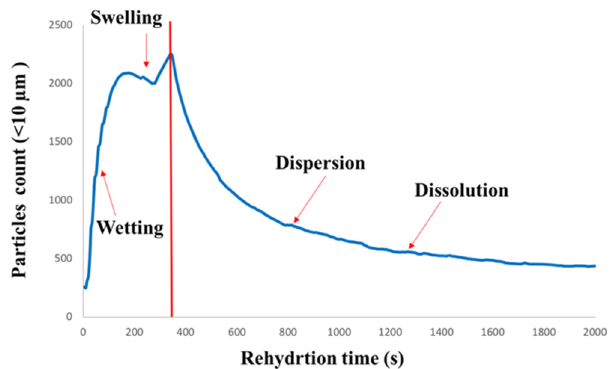
Figure 5. A typical fine particle count of chord length <10 µm plot vs. rehydration time. All four rehydration phases (wetting, swelling, dispersion, and dissolution) are identified on the figure as